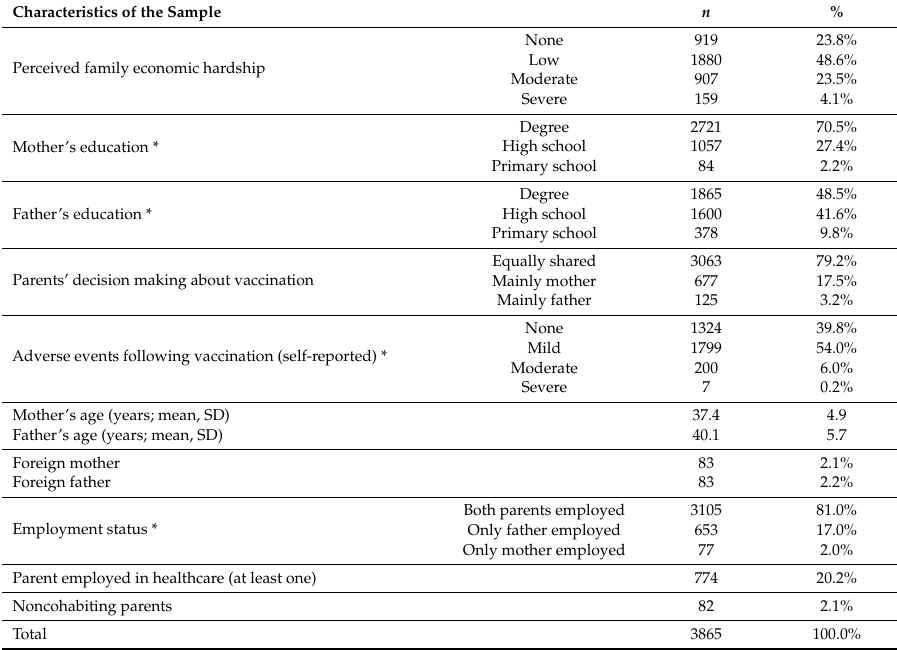
Table 1. Sociodemographic and health-related characteristics of study